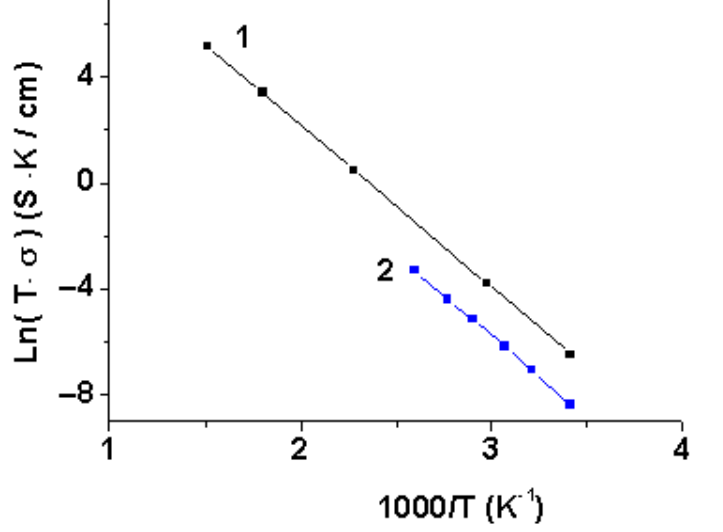
Figure 12. Temperature dependenciesfor the electrical conductivity of Li 3.8 Ge 0.9 S 0.1 O 4 solid electrolyte (1) andLi|Li 3.8 Ge 0.9 S 0.1 O 4 |Li 1.3 V 3 O 8 electrochemical cell (2). The voltametric study of the Li|Li 3.8 Ge 0.9 S 0.1 O 4 |Li 1.3 V 3 O 8 cell was conducted across the 1.5–4.5 V potential range at the scanning rate of 1 mV/s at 100 ◦ C. The current–voltage curve for the 3rd cycle of potential sweep is presented in Figure